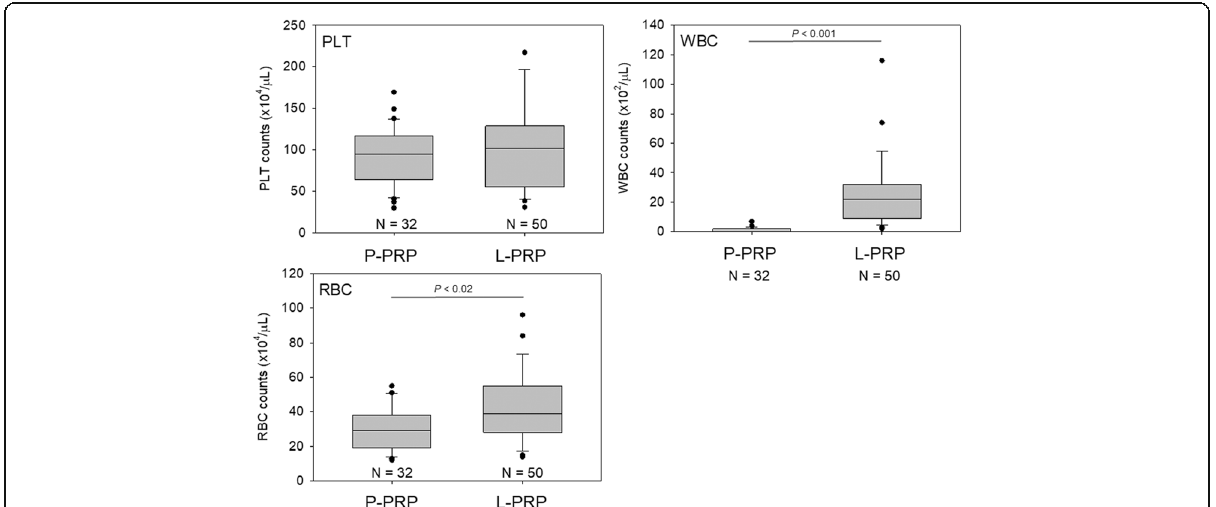
Fig. 5 Counts of platelets (PLT), WBCs, and RBCs in P-PRP and L-PRP preparations prepared for validation testing. N = 32 and 50 for P-PRP and L-PRP, respectively